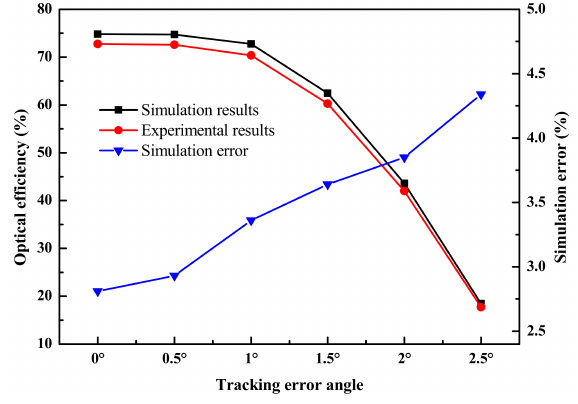
Figure 11. The optical efficiency and the simulation error for various tracking error angle.